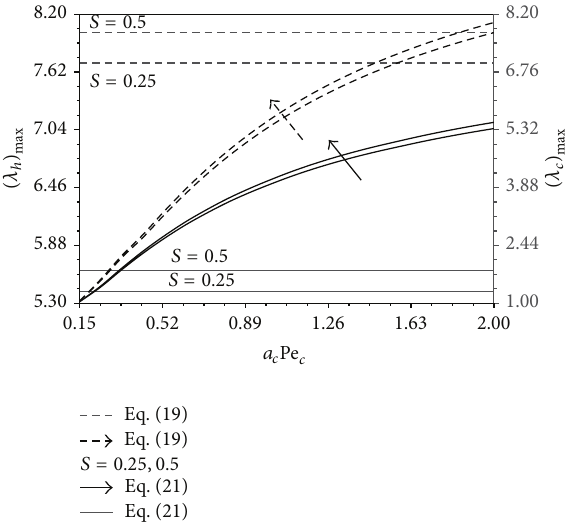
≤ 0.6, 0.05 ≤ 𝜙 𝑐 Pe 𝑐 /𝐿 ≤ 𝐿 /𝐿) . 𝑜 𝑚